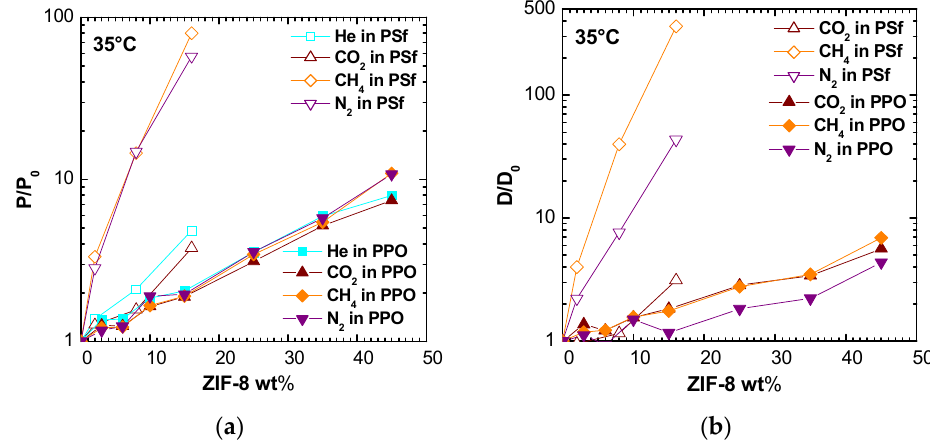
Figure 15. Comparison between ( a ) permeability and ( b ) diffusivity enhancement for various gases observed after addition of ZIF-8 to PSf (this work) and PPO ([19]) at 35 °C.